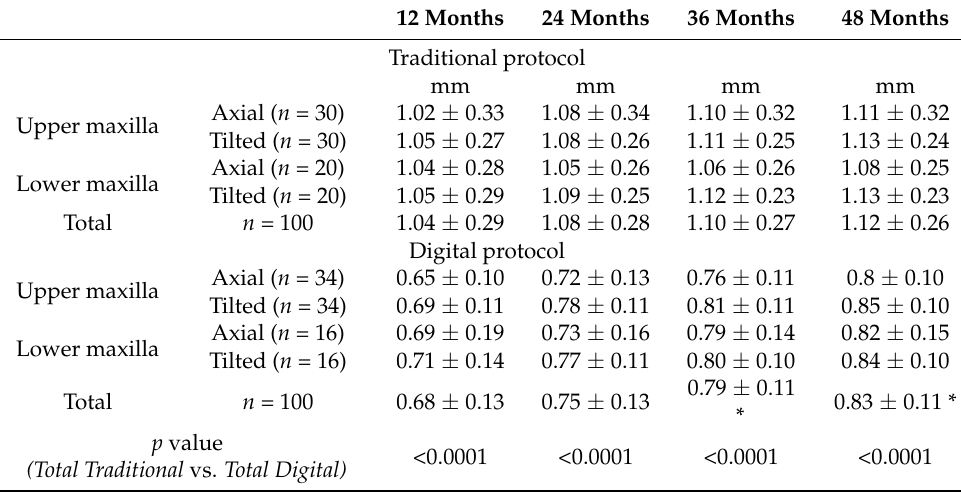
Table 4. Marginal bone